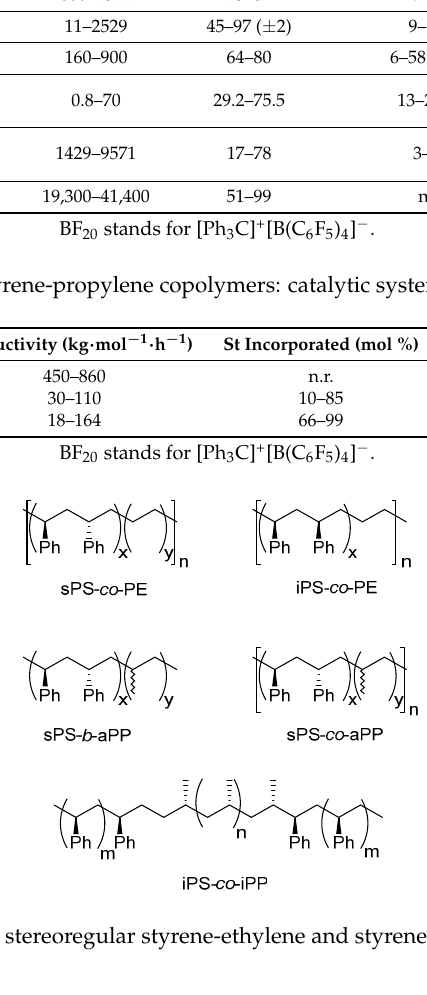
Table 1. Stereoregular styrene-ethylene copolymers: catalytic system and polymer properties.